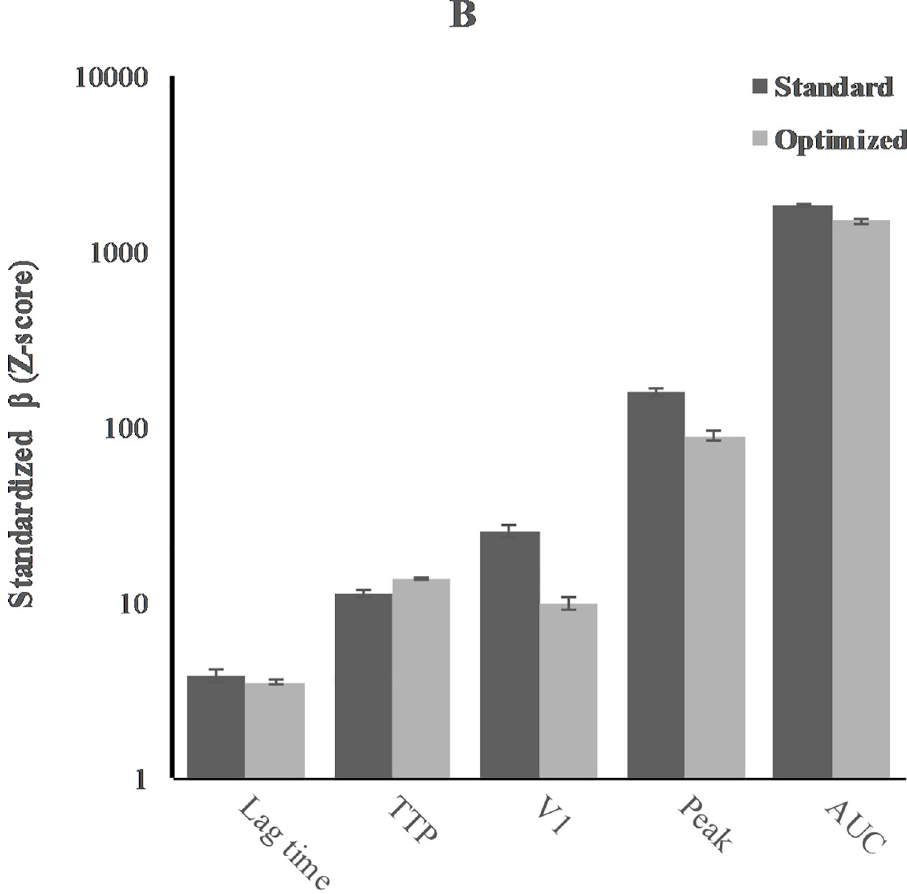
Fig 3. Effect of CTI on assay parameters for